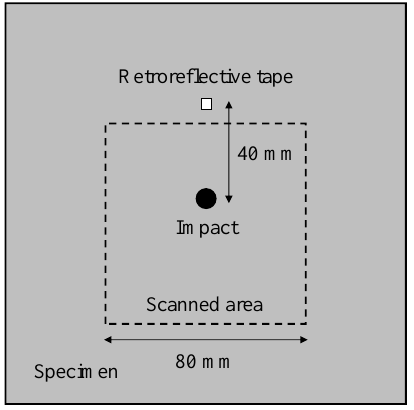
Figure 3. Schematic of the pulsed laser scanning area and the retroreflective tape position on the impacted specimen.